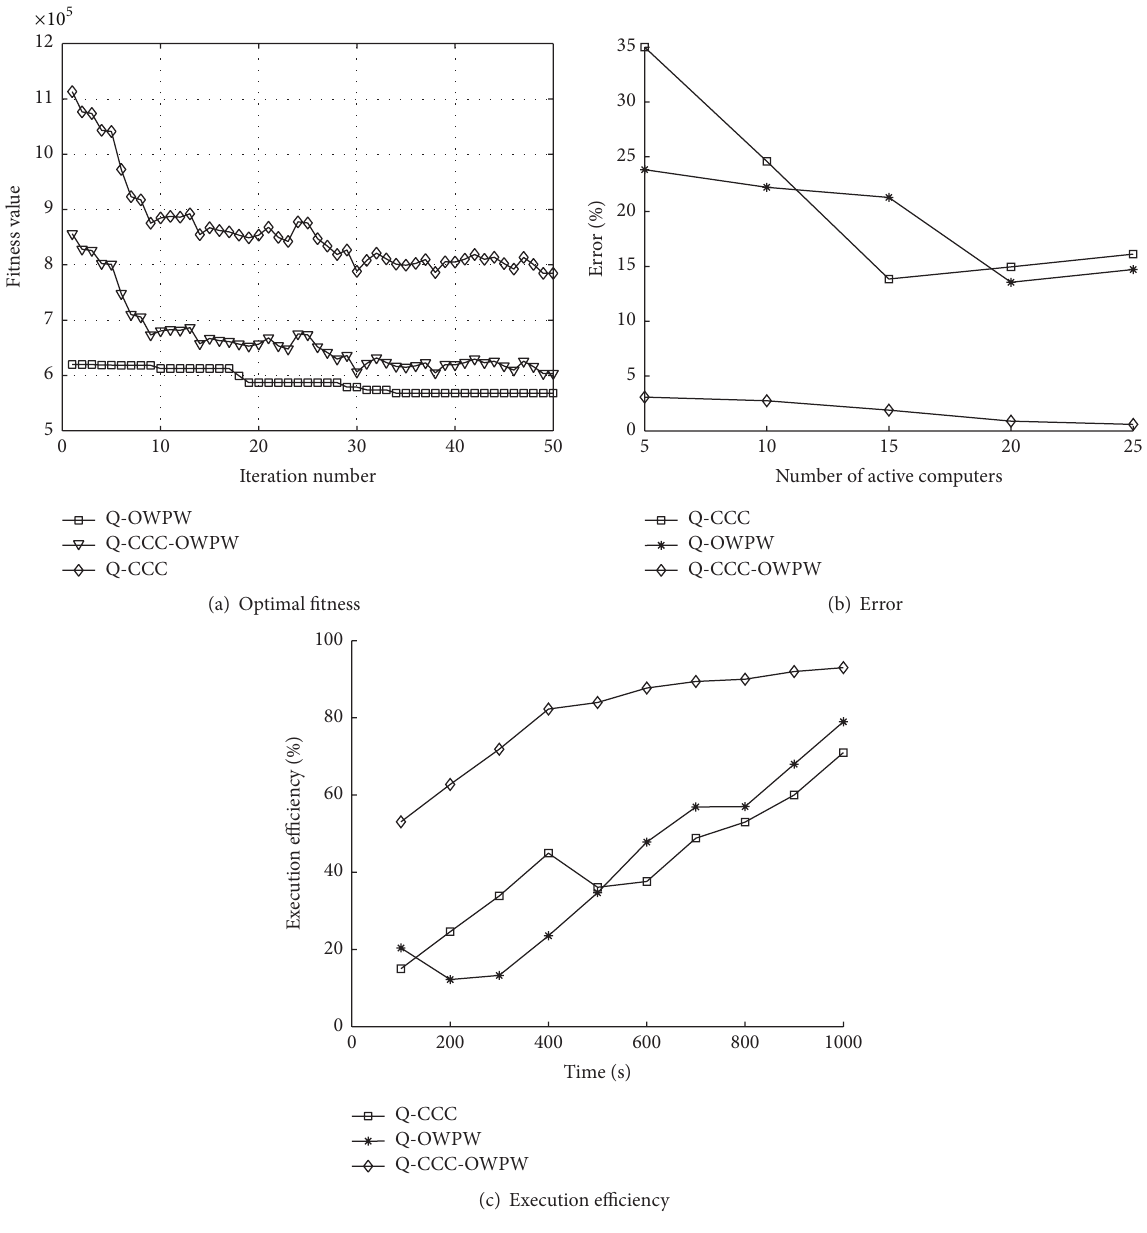
Figure 7: QoE guarantee